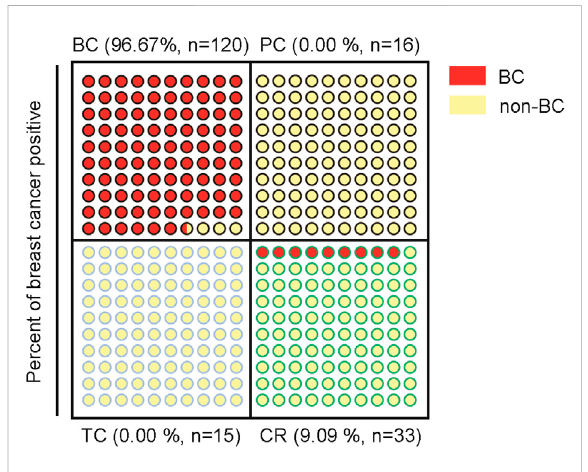
FIGURE 7 Schematic indication of the speci fi city for diagnosis of BC of the miR-19b-based 3-miRNA model in 4 different tumor